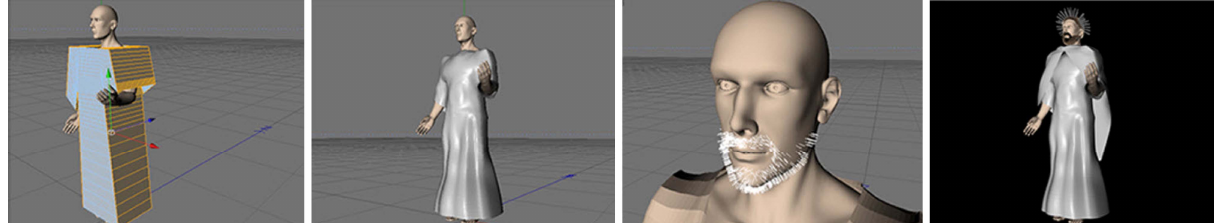
Figure 3. San Michele Chapel, San Romedio hermitage (TN): modelling and rendering process for the virtual simulation of